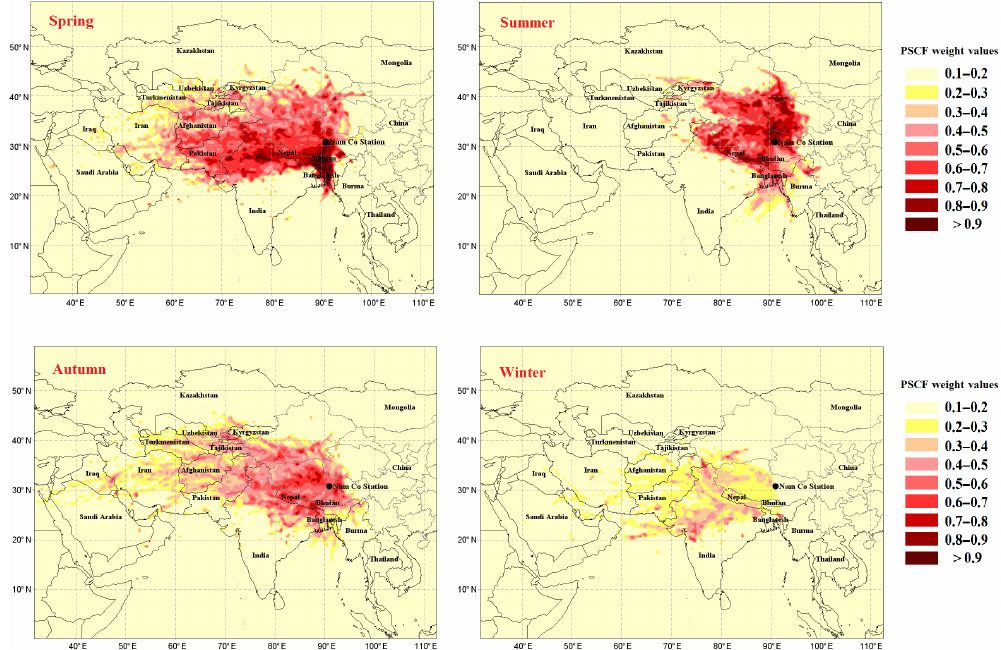
Figure 12. Likely source areas of air mass associated with higher surface ozone concentrations at Nam Co Station by season identified using